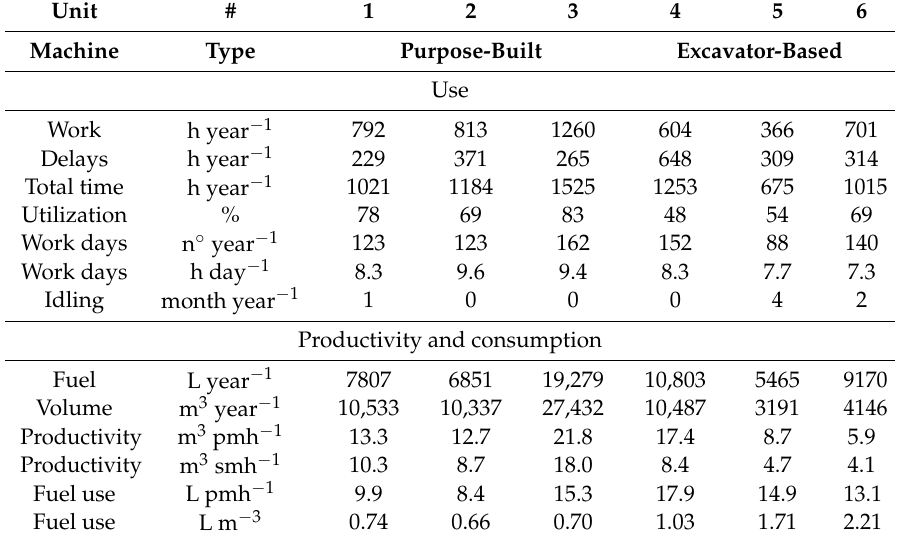
Table 2. Annual totals by test